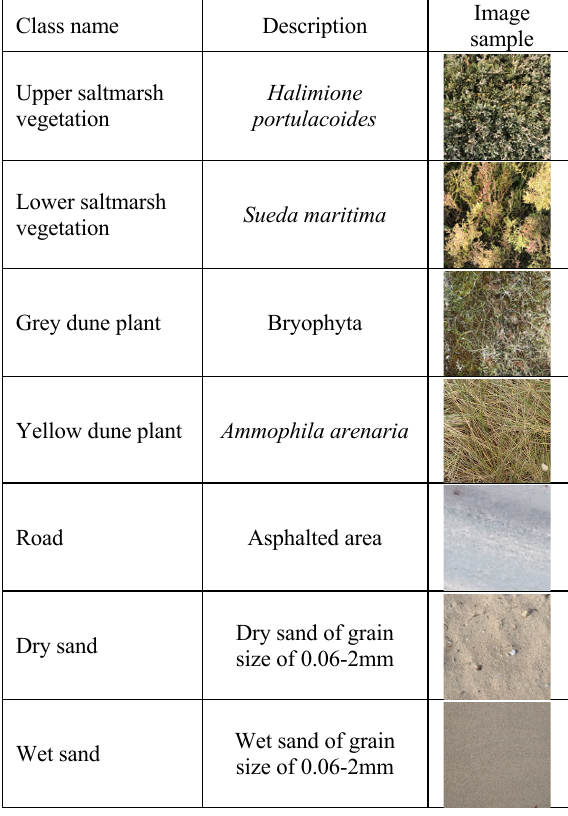
Table 1. Description of the seven ground-truth